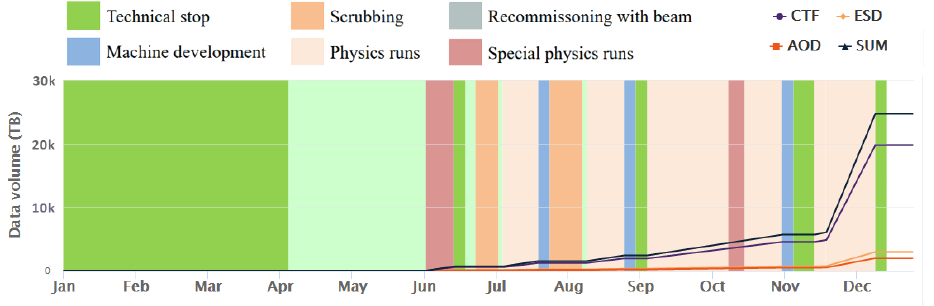
Fig. 4. Simulated amount of data by type during the 1st year of Run 3